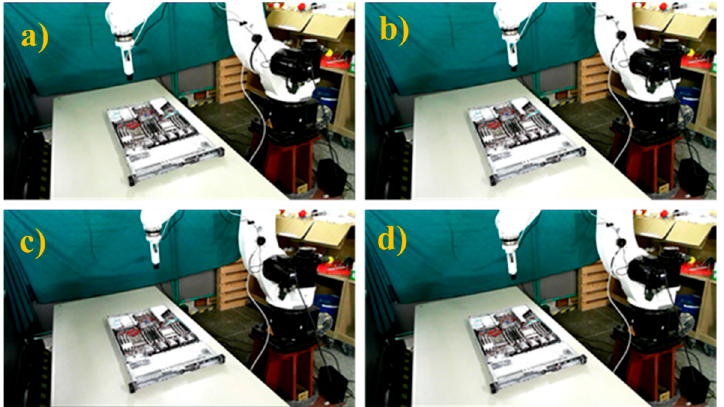
Figure 13. Four different robot poses to capture standard AOI targets images before manual